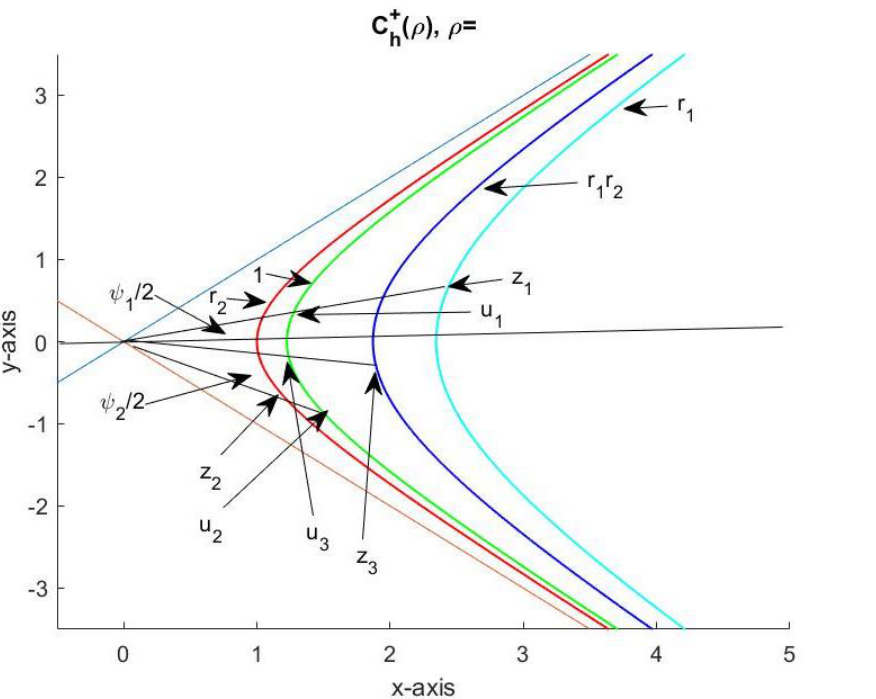
Figure 4. Hyperbolic vector multiplication within either X or Y means sector combination by adding the signed area contents and multiplying the hyperbolic radii r 1 and r 2 of sectors S ( o , u 1 , e ) and S ( o , u 2 , e ) where u k = z k , k = 1,2 and z k = Hyp ( r k , ψ k ) , k = r k